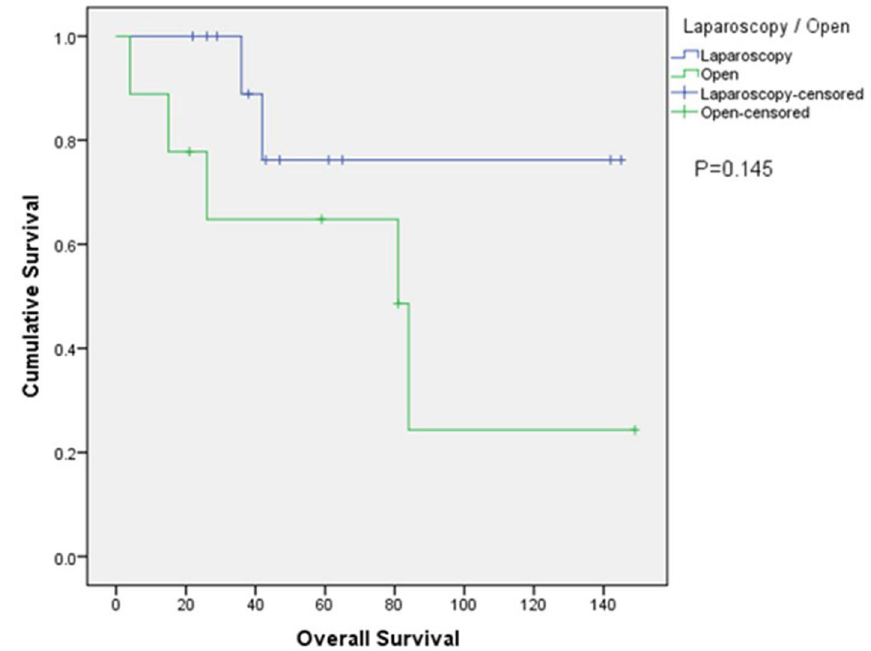
Figure 5. Kaplan–Meier plot of overall